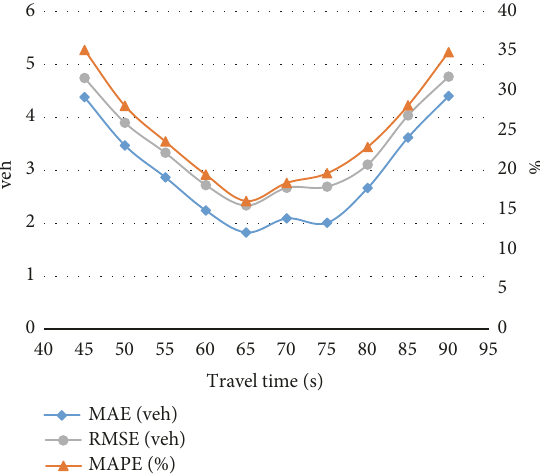
Figure 11: Average MAE, MAPE, and RMSE of maximum queue length at different travel